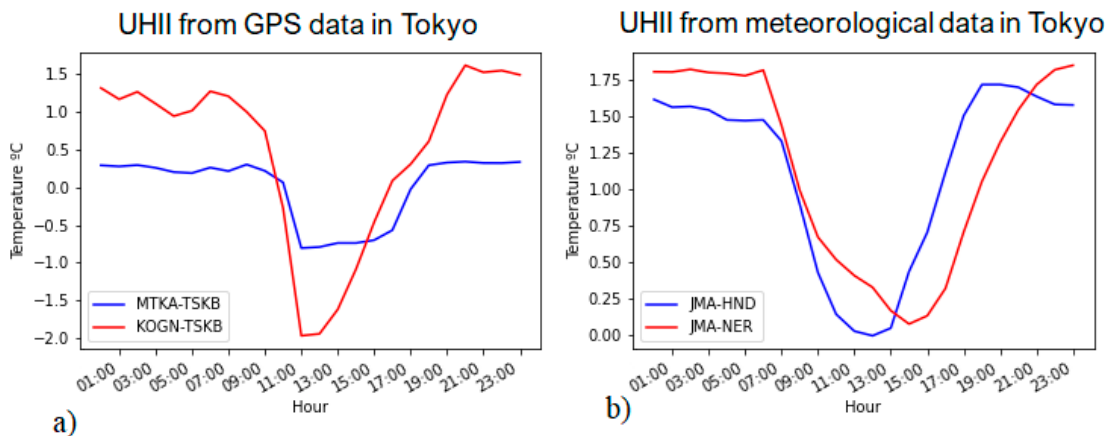
Figure 5. AUHI intensity in Tokyo ( a ) estimated with GPS data and ( b ) measured with meteorological data. Local time in Tokyo is UTC+9. data. Local time in Tokyo is UTC+9.